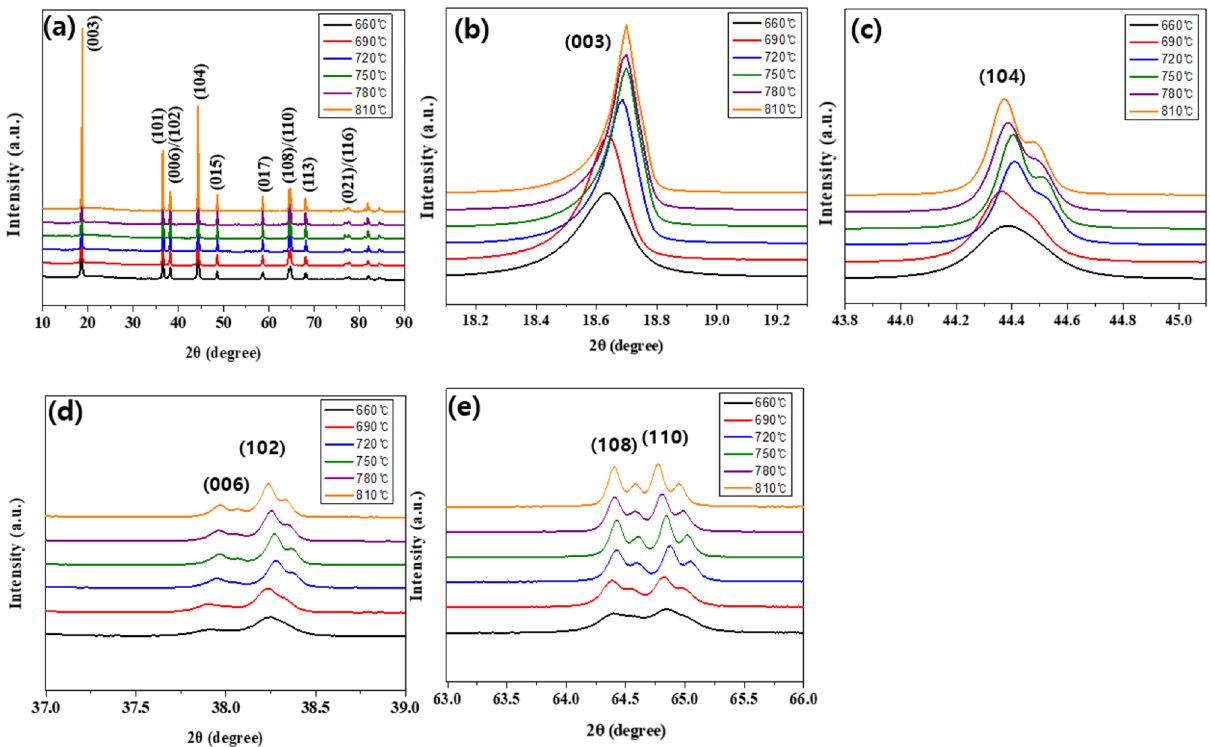
Figure 1. ( a ) XRD patterns and magnified views of the ( b ) (003) peaks, ( c ) (104) peaks, ( d ) (006)/(102) peaks and ( e ) (108)/(110)